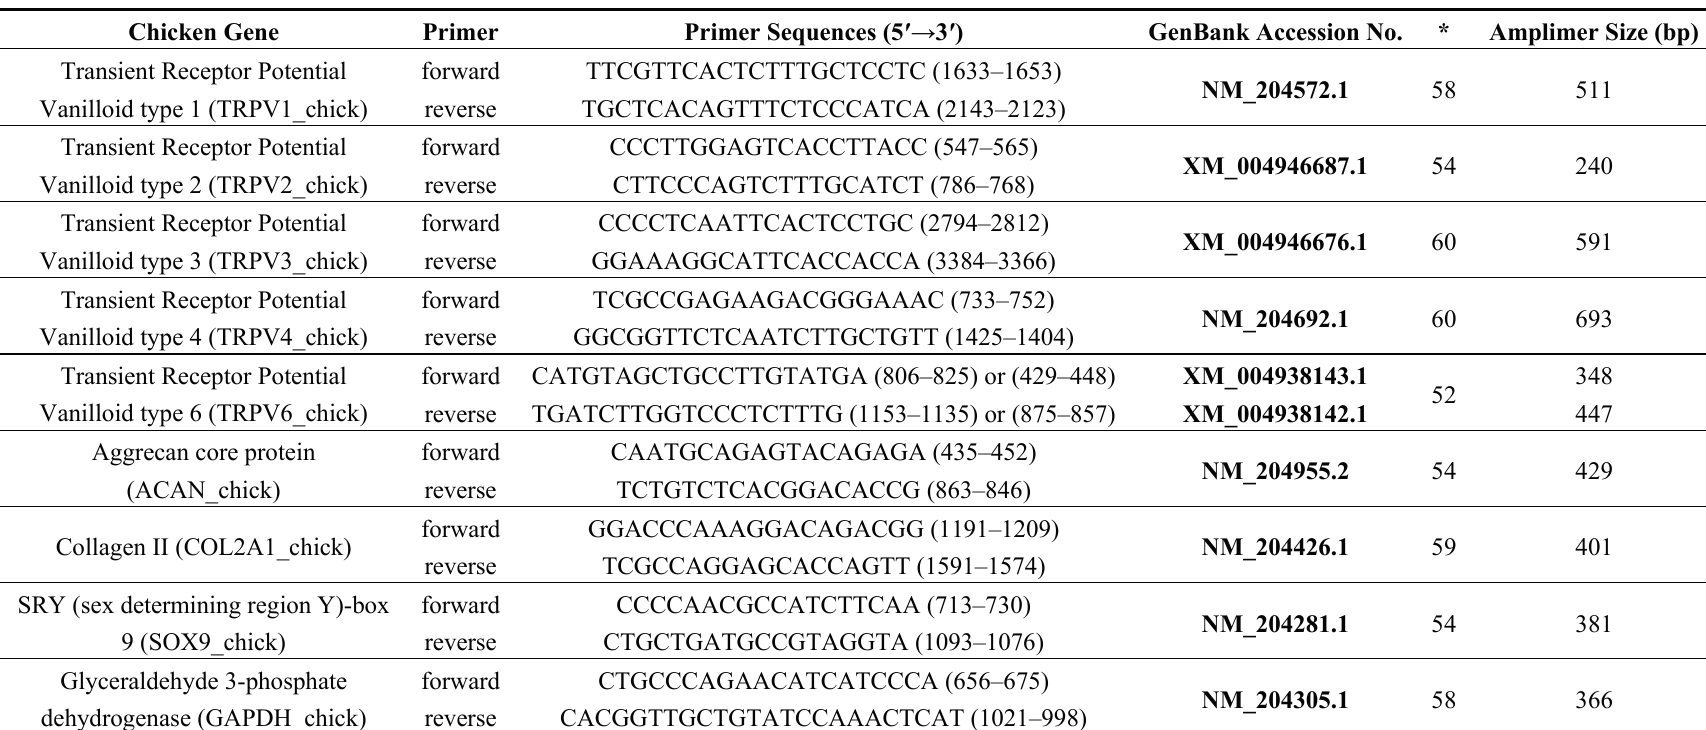
Table 1. Nucleotide sequences, amplification sites, GenBank accession numbers, amplimer sizes and PCR reaction conditions for each chicken primer pair are shown. * annealing temperature